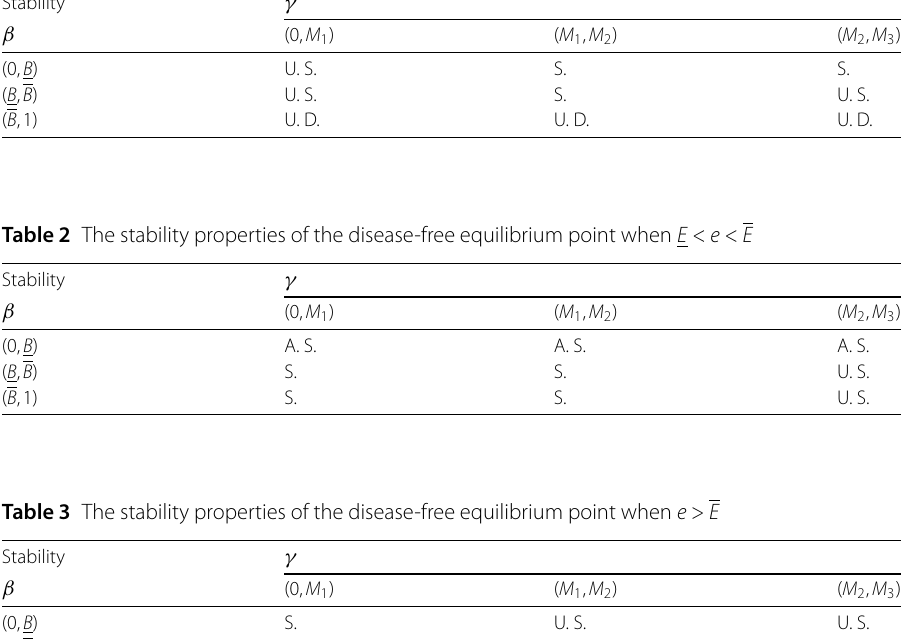
Table 1 The stability properties of the disease-free equilibrium point when e < E Stability